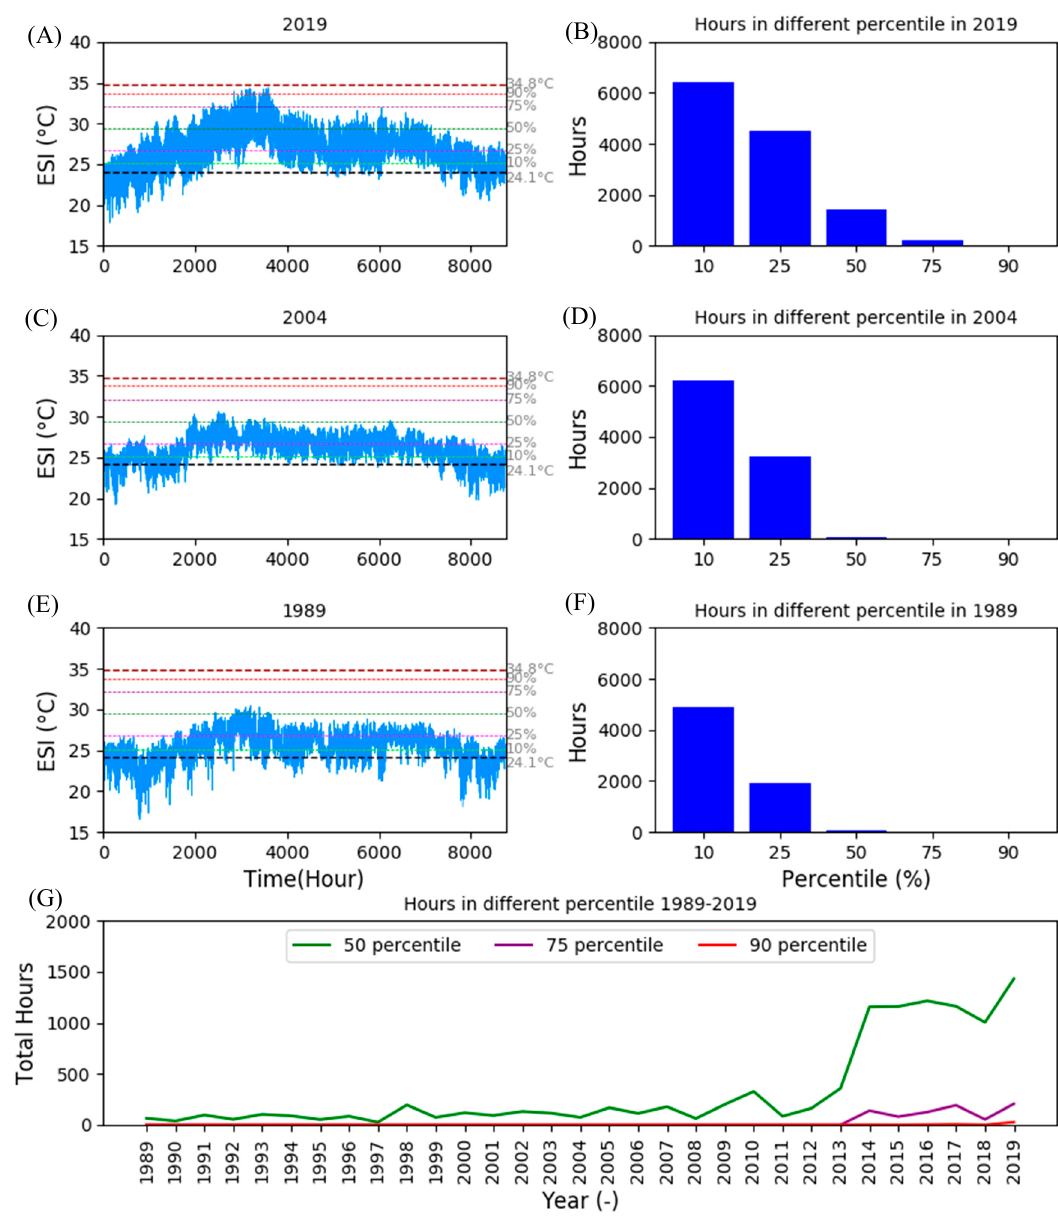
Figure 3. Environmental stress index (ESI) analysis for Auroville (1989–2019). Hourly ESI in ( A ) 2019, ( C ) 2004, and ( E ) 1989; thick dotted lines at 34.8 ◦ C and 24.1 ◦ C are the upper and lower values of the typical range of ESI for Auroville; the dotted thinner lines denote 10th, 25th, 50th, 75th, and 90th percentiles (bottom to top) between the typical ESI range. The number of hours in 10th, 25th, 50th, 75th, and 90th percentile in ( B ) 2019, ( D ) 2004 and ( F ) 1989. ( G ) Total hours in top 50th, 75th and 90th percentile of typical ESI range between 1989 and 2019 for Auroville.